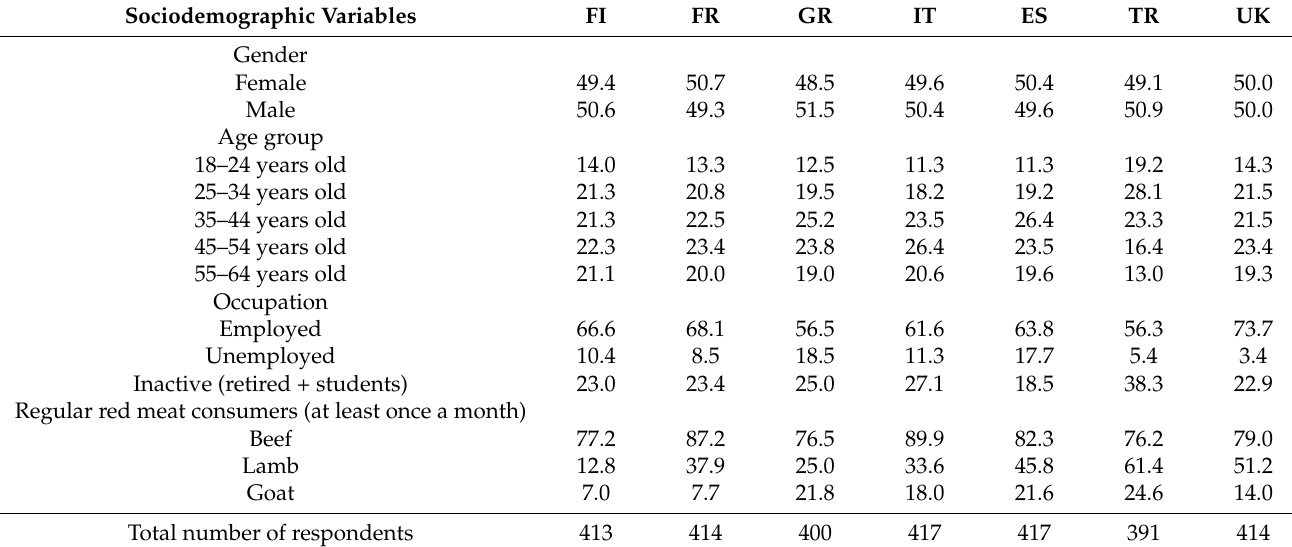
Table 3. Sociodemographic characteristics of the sample in percentages by country. Sociodemographic